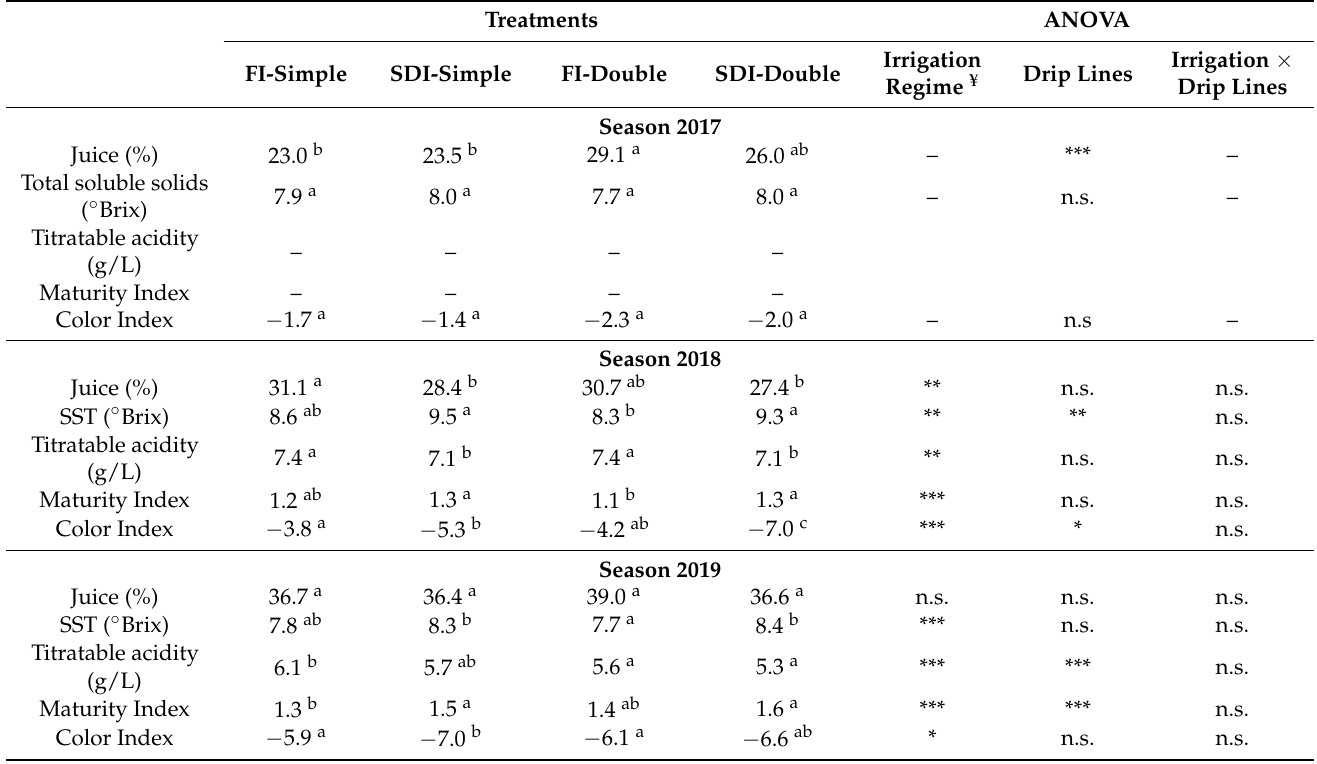
Table 8. Effects of the different irrigation regimes carried out in the lemon trial on fruit composition. The statistical significance for the different factors included in the ANOVA is also included. ***, **, *, and n.s., mean significant differences at p < 0.001, p < 0.05, p < 0.1, and non-significant differences between treatments, respectively. Within each row, different letters indicate significant differences between